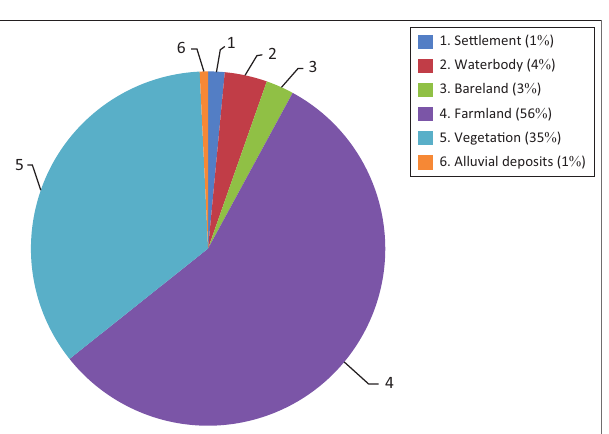
FIGURE 8: Land cover and land use affected by 2002 flooding in Adamawa.